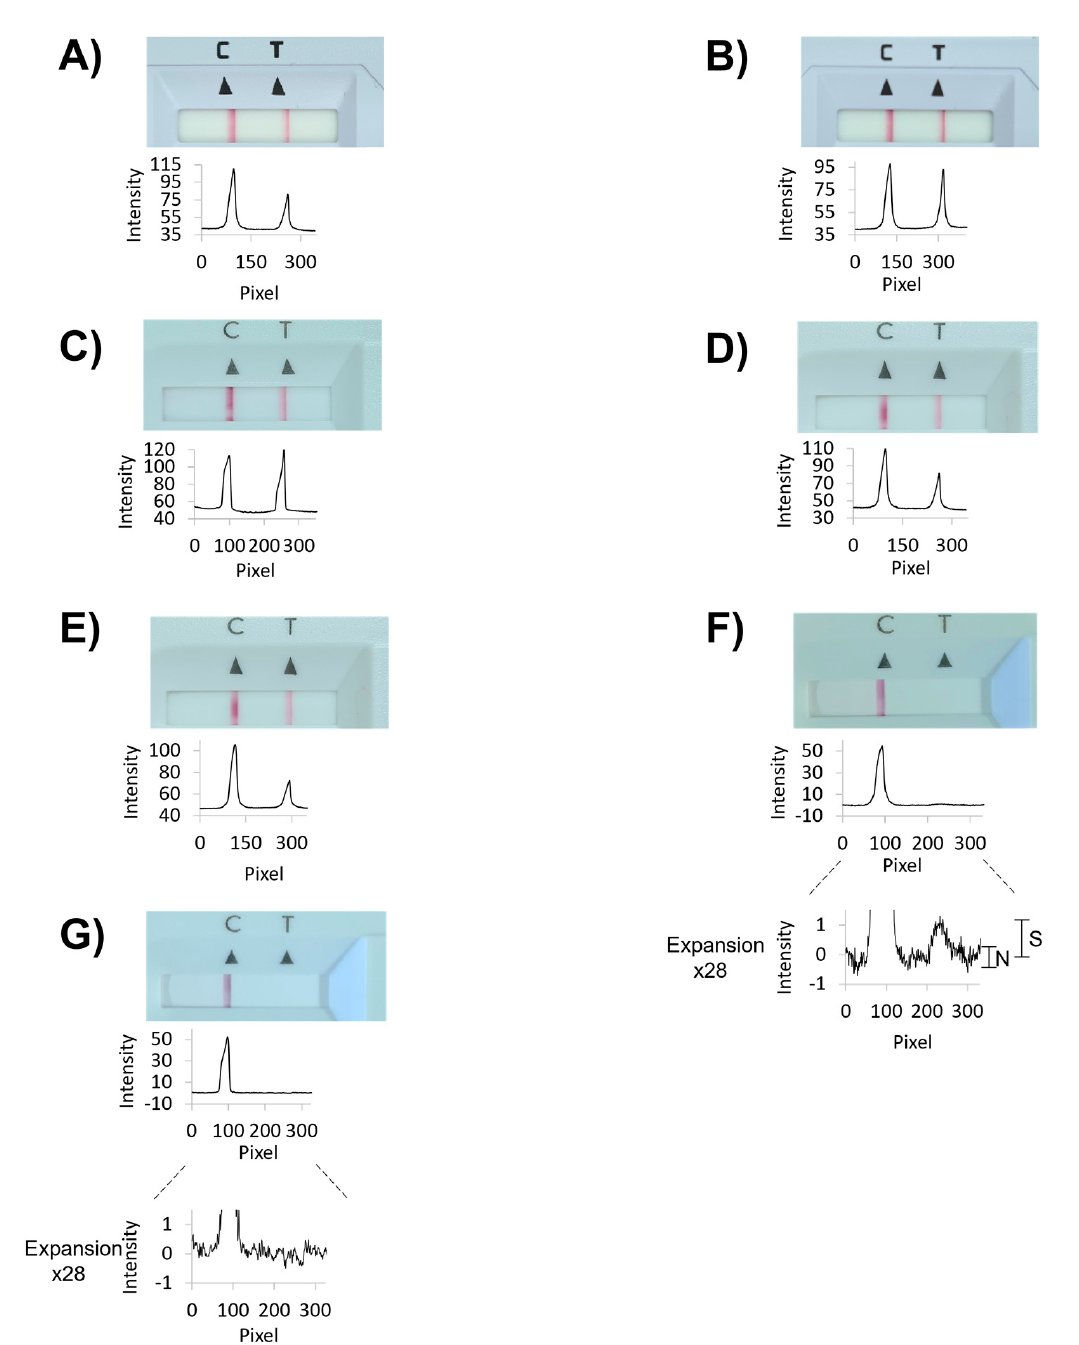
Figure 4. Representative results from rapid antigen tests with or without pooling. Photographs of the read-out window of lateral flow assay cassettes are shown, together with signal intensity plots for each test results, as obtained by integration with ImageJ. Except when otherwise noted, photographs were taken 15 min after the start of the assay using the Abbott PanBio test. ( A ) Standard Roche test with a single positive control swab. ( B ) Same as ( A ) but after 30 min. ( C ) Abbott assay with a positive control swab only. ( D ) Pool of five nasopharyngeal 50 µ L swabs from healthy volunteers and one positive control swab. ( E ) Five cotton wool 100 µ L swabs and one positive control swab. ( F ) Same as ( E ), but with 32-fold dilution with extraction buffer. An expanded view of the integration plot is shown below the original plot. ( G ) Six pooled cotton wool swabs from healthy volunteers. An expanded view of the integration plot is shown below the original plot. See Table 1 for numerical values obtained by integration and further experimental details.